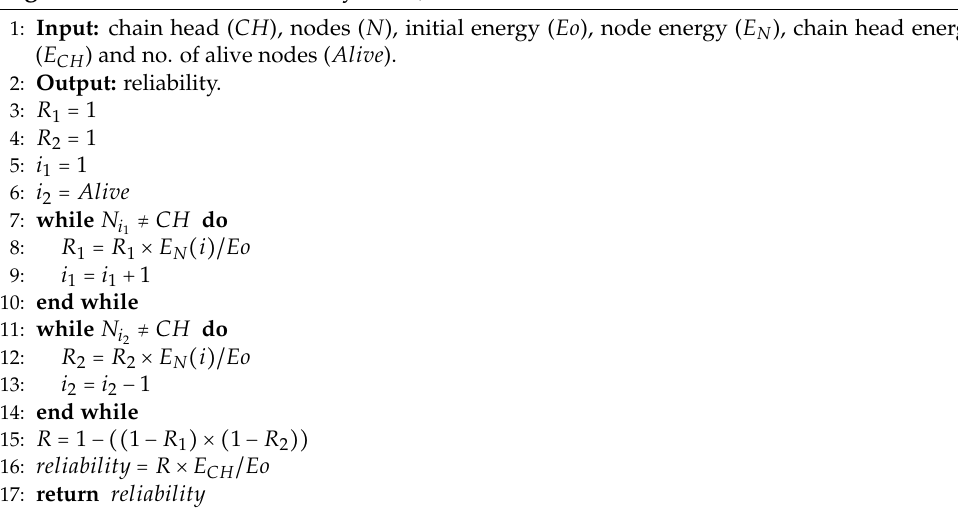
Algorithm 2 Calculate reliability of SQ-Chain.